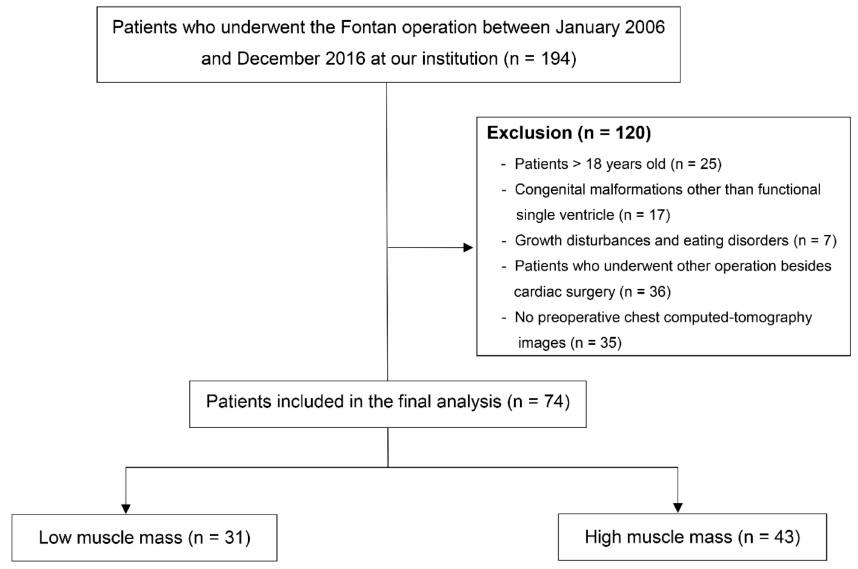
Figure 2. Flowchart of the patient selection and classification. Table 1. Clinical characteristics of 74 pediatric patients who underwent the Fontan